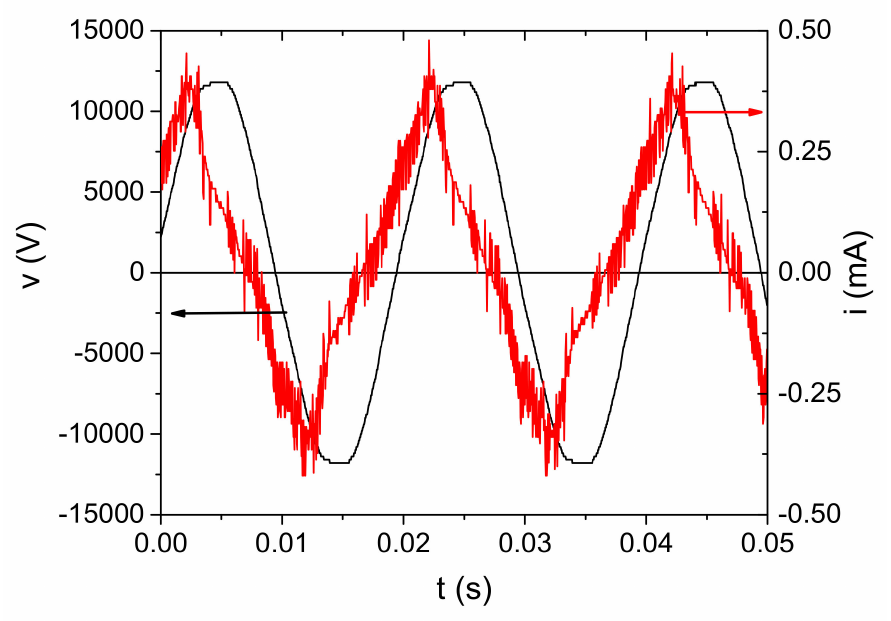
Figure 6. Time dependence of voltage and current signals at V input = 220 V and d = 5 mm for the discharge operating in air.